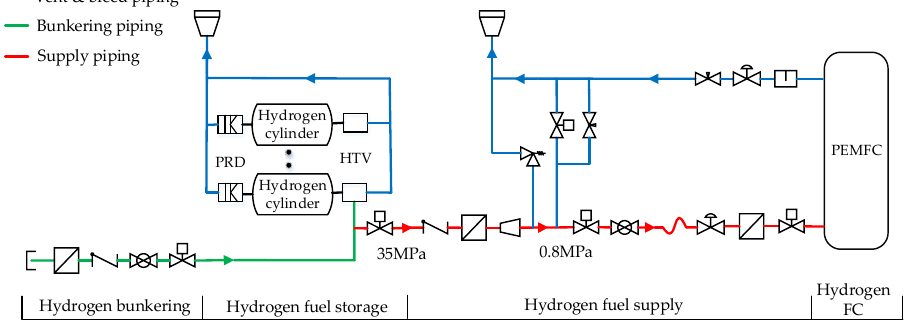
Figure 5. Hydrogen gas supply system.